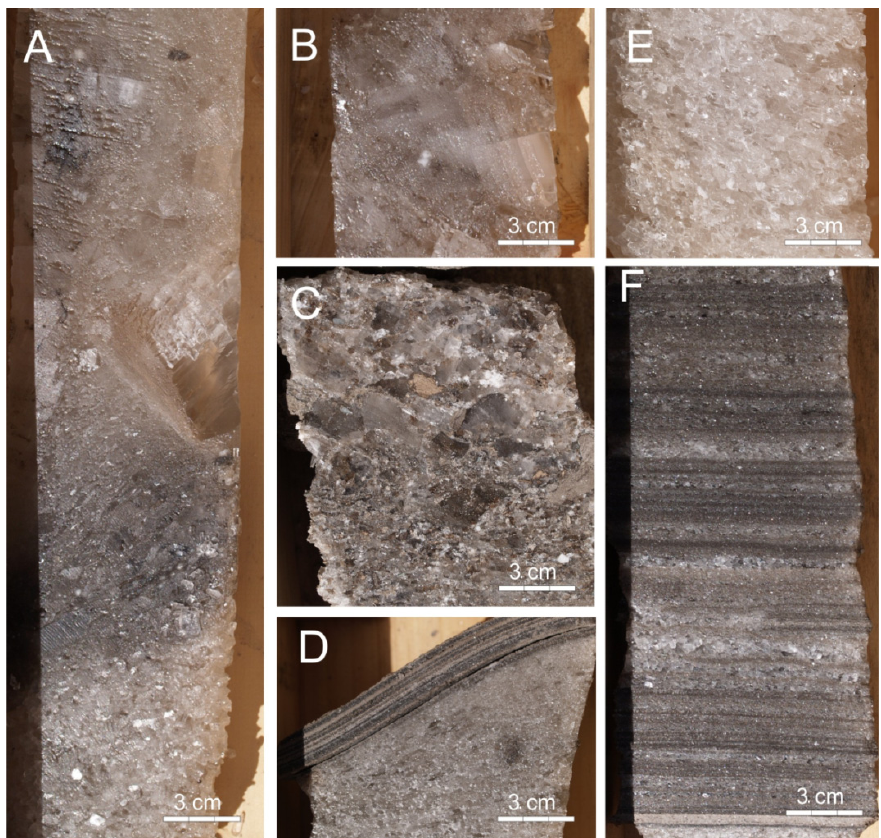
Figure 4. Various types of salt rocks drilled by the Huwniki-1 well. ( A ) Pure recrystallized halite crystals (up to 50 mm large), within coarse-grained salt; depth: 4991.4 m. ( B ) Well-preserved chevron (“milky chevron”: inclusion-rich fluid) halite crystals; depth: 4994.7 m. ( C ) Halite–rudite (or salt breccias): structureless debris of halite crystals, mixed with anhydrite nodules and containing mudstone clasts, located within fine to the pelitic matrix, representing normal grading; depth: 4995.8 m. ( D ) Laminated mudstone, with anhydrite above medium-grained, porphyritic-textured grey salt; depth: 4998.0 m. ( E ) Medium-grained white salt, granoblastic texture, with sutured boundaries between fusiform crystals; depth: 4998.3 m. ( F ) Fine- and medium-grained grey salt, laminated with clay, silt, and fine grains of nodular anhydrite; depth: 4998.7